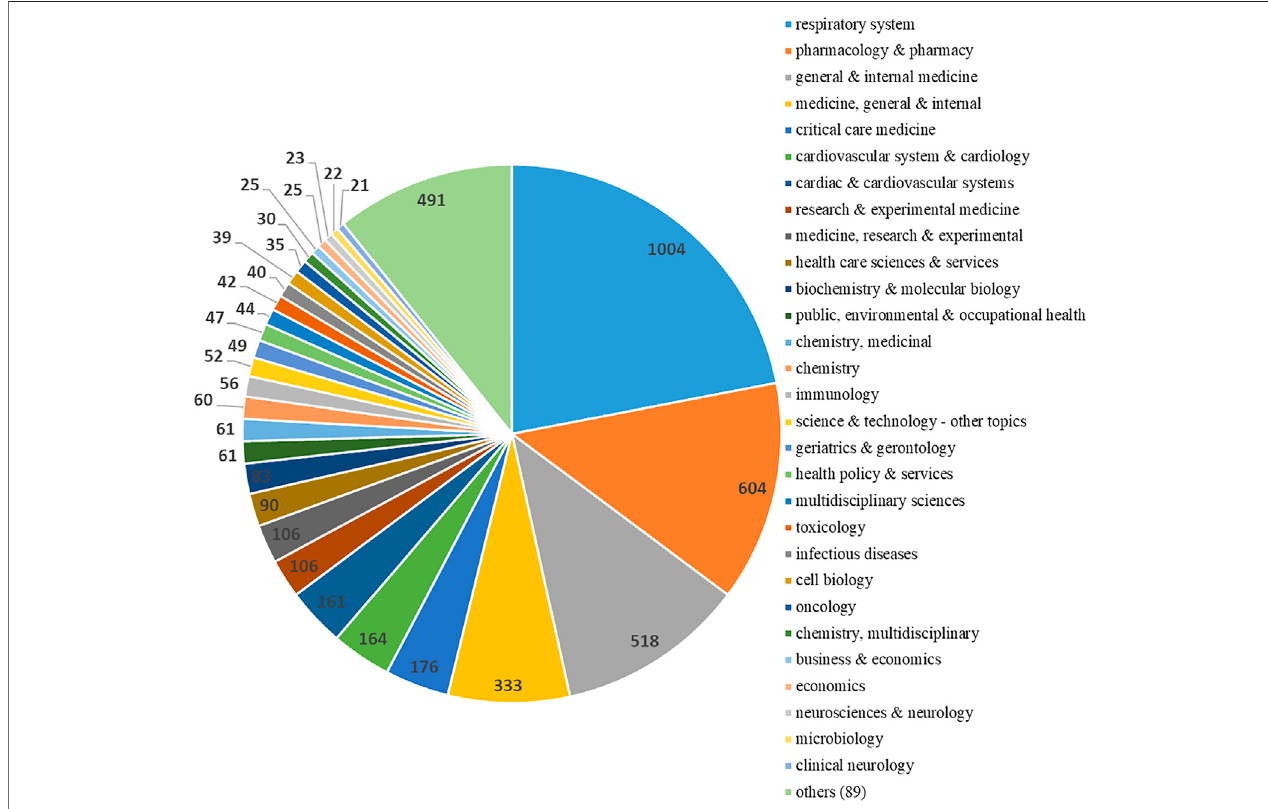
FIGURE 7 | Research areas of COPD drugs-related studies that were published from 1980 to 2021.